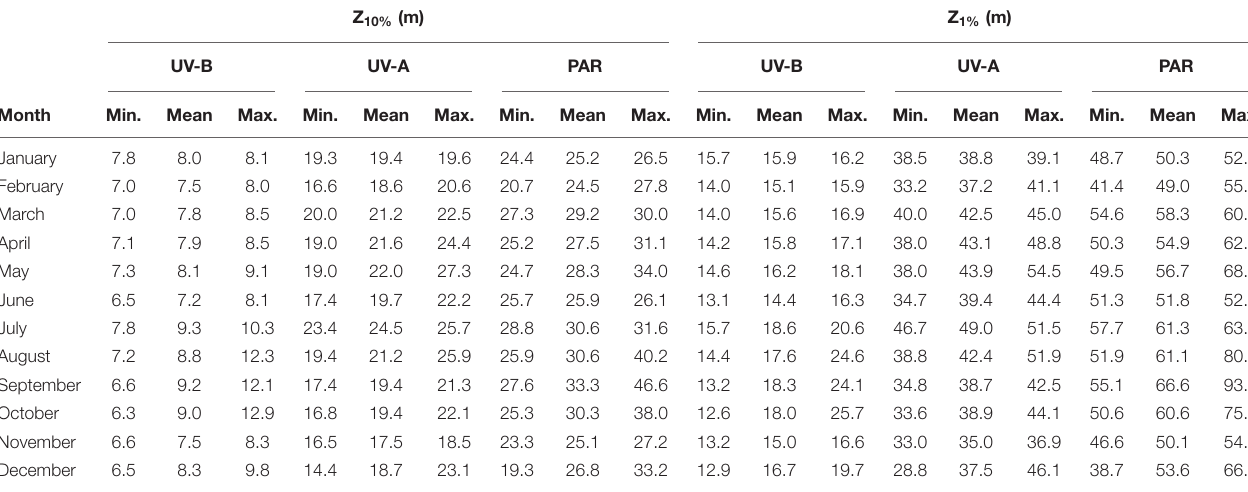
TABLE 3 | Percent attenuation depths (Z 10% and Z 1% ) for the UV-B (280–315 nm), UV-A (315–400 nm), and PAR (400–700 nm) spectra. Z 10% (m) Z 1% (m) UV-B UV-A PAR UV-B UV-A